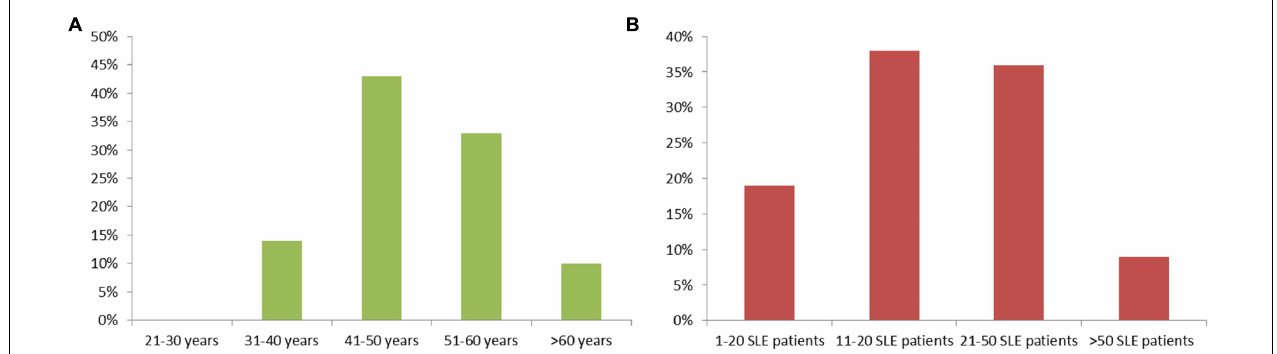
FIGURE 1 | (A) Age distribution of survey respondents, and (B) numbers of SLE patients treated by each survey respondent.